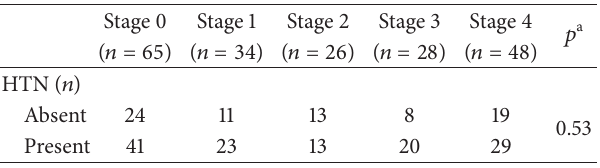
Table 2: Distribution of the hypertension presence of patients according to